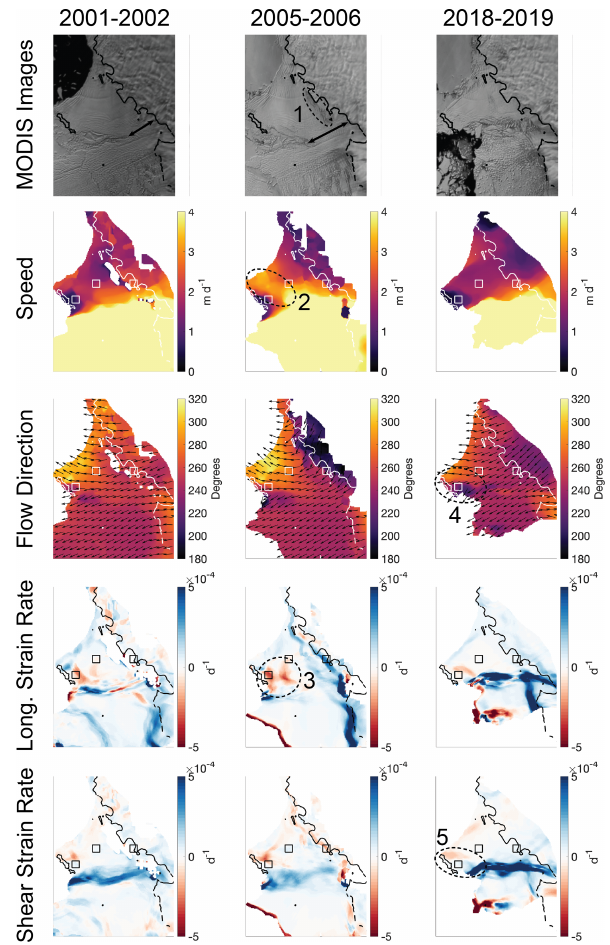
Figure 4. Annual maps of TEIS variables. Arrows in the first two MODIS images indicate the length of the shear margin connecting the TEIS and TWIT early in the record. Dashed ovals 1, 2, and 3 highlight the crevasse swarm downstream of the grounding line, mid-shelf speed increase, and mid-shelf compressive strain rates, respectively, that all occurred around 2005–2006. Dashed ovals 4 and 5 highlight the flow direction split around the pining point and the resulting regions of contrasting sense of shear strain that are ob- served late in the